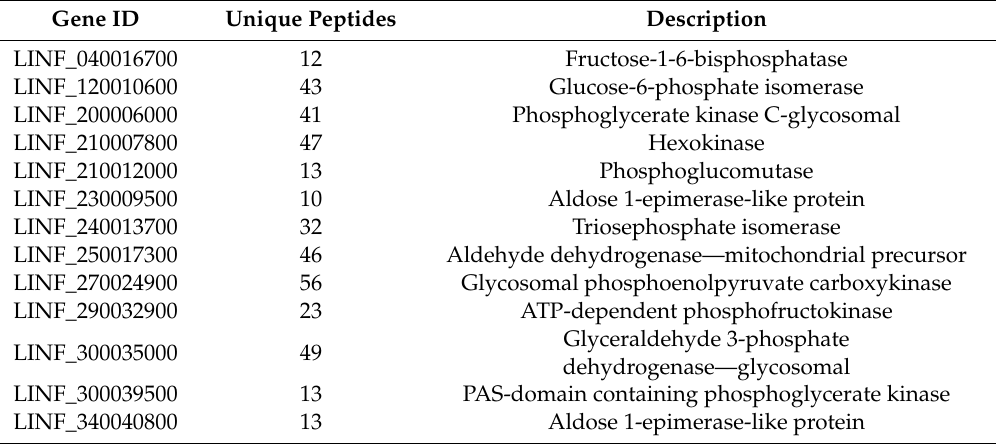
Table 1. List of glycosomal enzymes related to gluconeogenesis and glycolysis identified in L. infantum (according to the Kyoto Encyclopedia of Genes and Genomes (KEGG) pathway database).